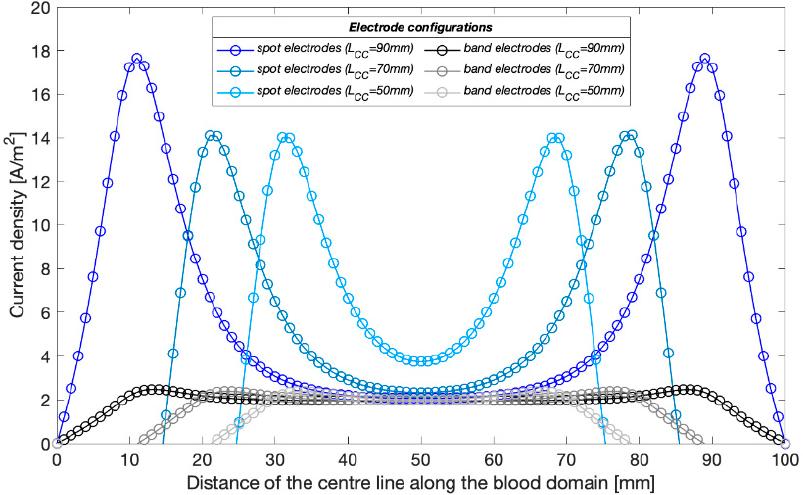
Figure 11. Current density distribution along the blood ‐ filled artery centre of the wrist model 1 with different CC electrodes configuration at 100 kHz.